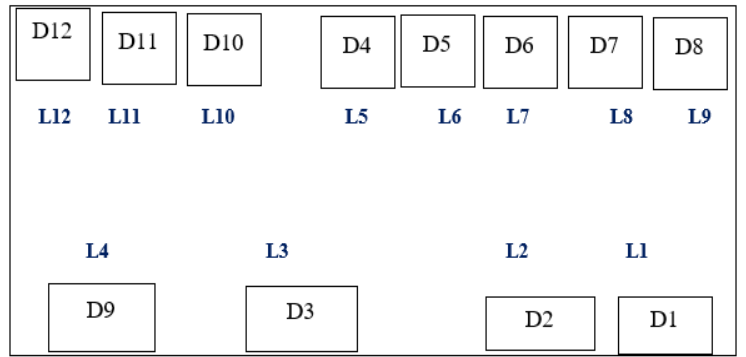
Figure 6. Layout of the OPC showing locations and assigned departments. Table 3. Comparison of waiting time and cycle times with increase in demand for different layout redesigns.